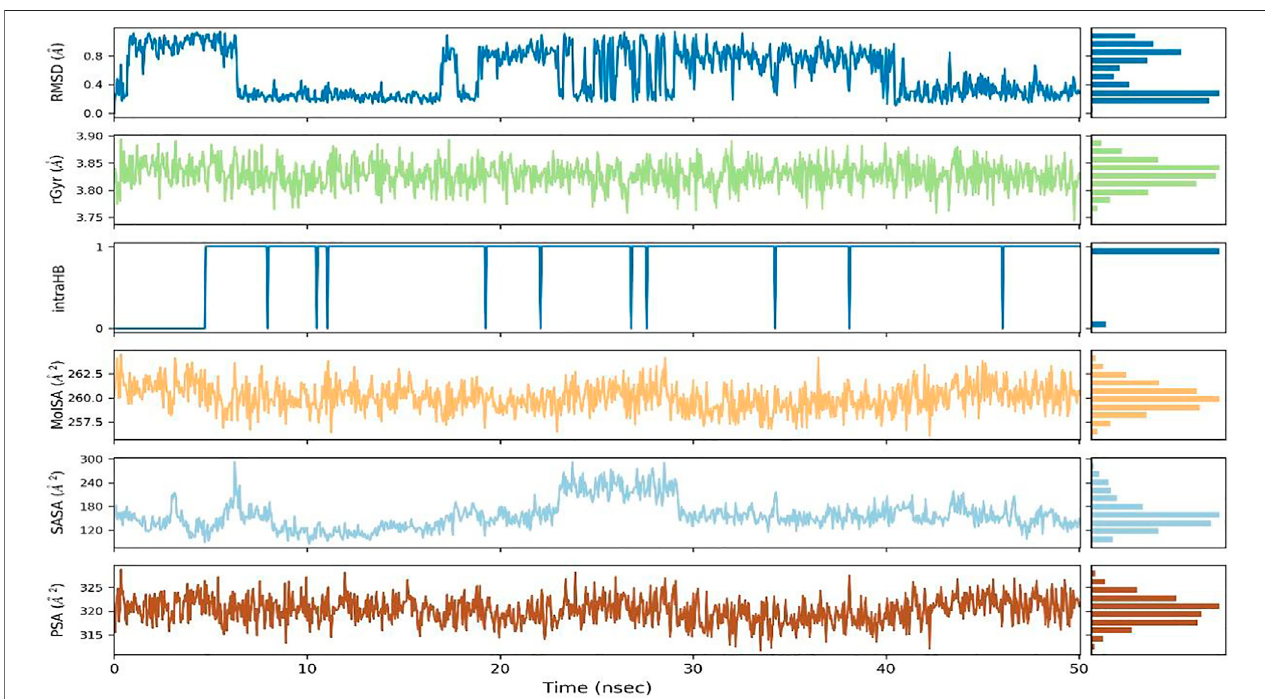
FIGURE 3 | Ligand RMSD, Radius of Gyration (rGyr), Intramolecular Hydrogen Bond (intraHB), Molecular Surface Area (MolSA), Solvent Accessible Surface Area (SASA), Polar Surface Area (PSA) as calculated during the 50 ns of MD Simulation.